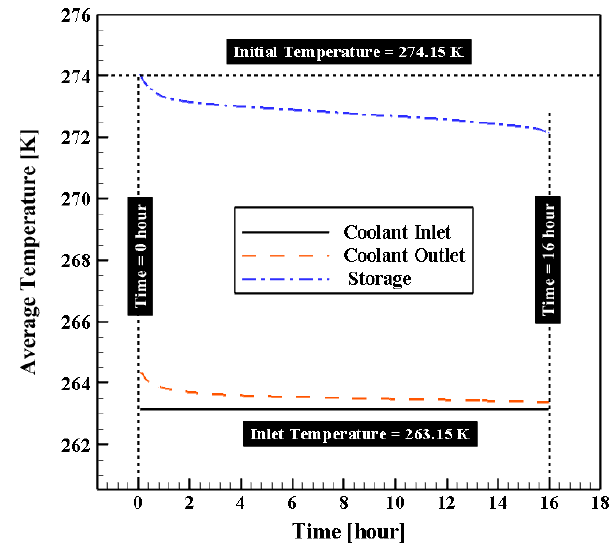
Figure 3. Comparison between the inlet and outlet temperatures of the coolant fluid at Re = 2000 and T inlet = 263.15 K.